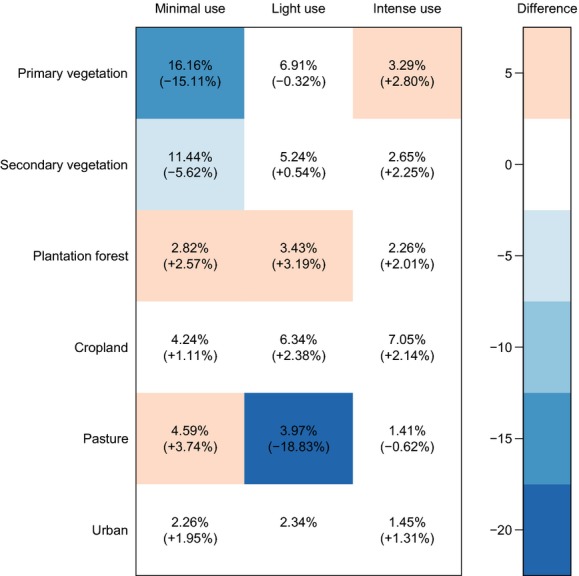
Representativeness of predominant land use and land-use intensity classes. Numbers are the percentage of Sites assigned to each combination of land use and intensity. Numbers in brackets and colors are the differences between these and the proportional estimated total terrestrial area of each combination of land use and land-use intensity for 2005, computed from the HYDE (Hurtt et al. 2011) and Global Land Systems datasets (van Asselen and Verburg 2012); no difference is shown for “Urban”/”Light use” because these datasets did not allow us to compute an estimate for this combination. The 12.15% of Sites that could not be assigned a classification for predominant land use and/or land-use intensity are not shown.